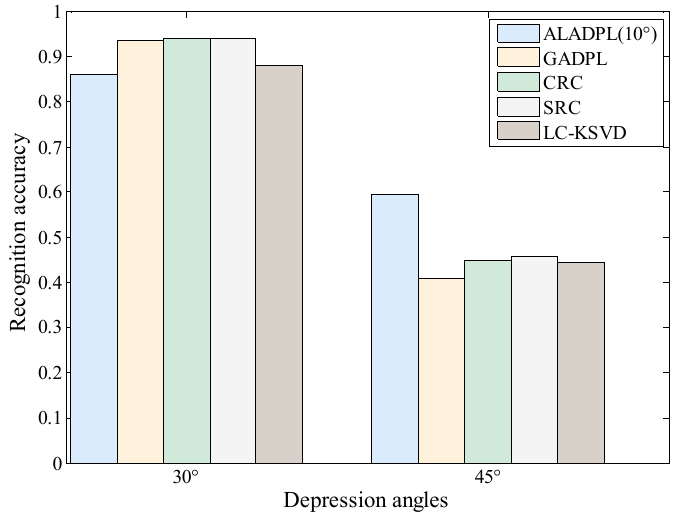
Figure 22. Performance of the algorithms in large depression angle experiment.